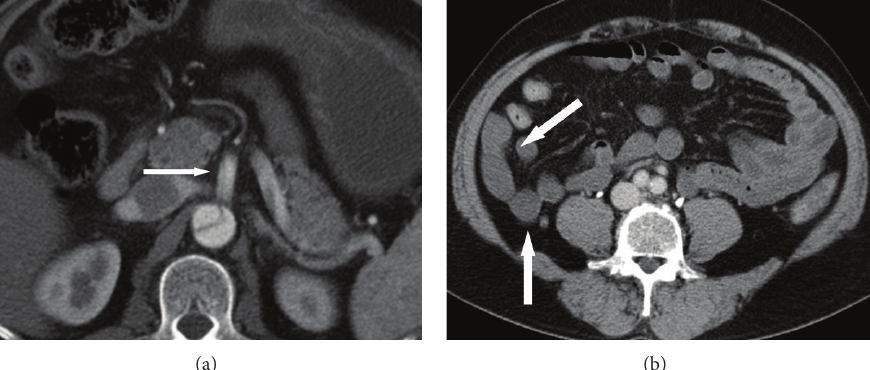
Figure 1: Contrast-enhanced CT shows (a) a type B aortic dissection, dissected SMA, and compressed true lumen (arrow) and (b) poor contrast enhancement of some of the small intestines (arrow).